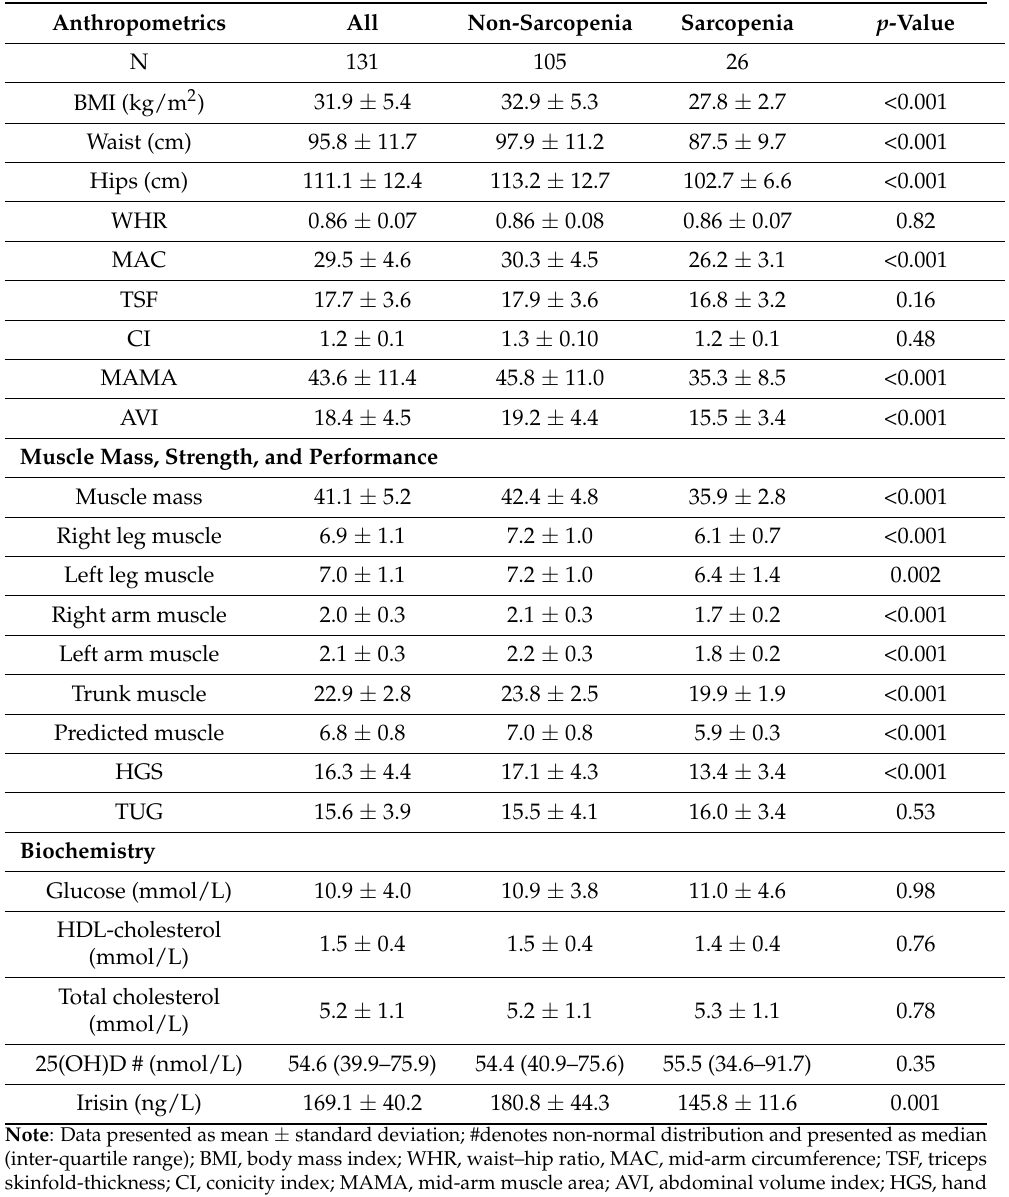
Table 2. Clinical characteristics of participants according to sarcopenia